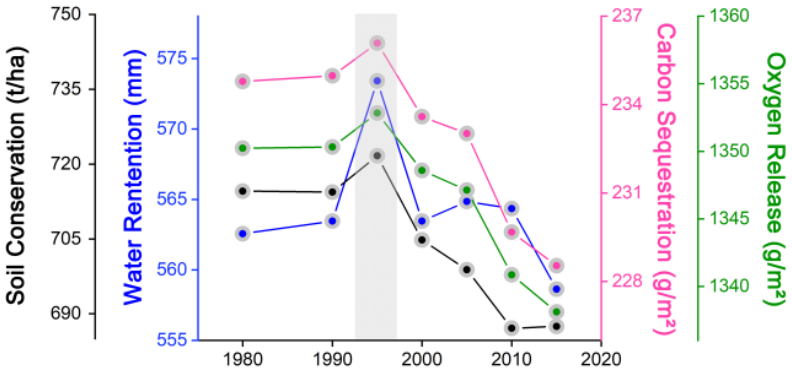
Figure 7. Time series diagram of ecosystem services in Hainan Island between 1980 and 2015.